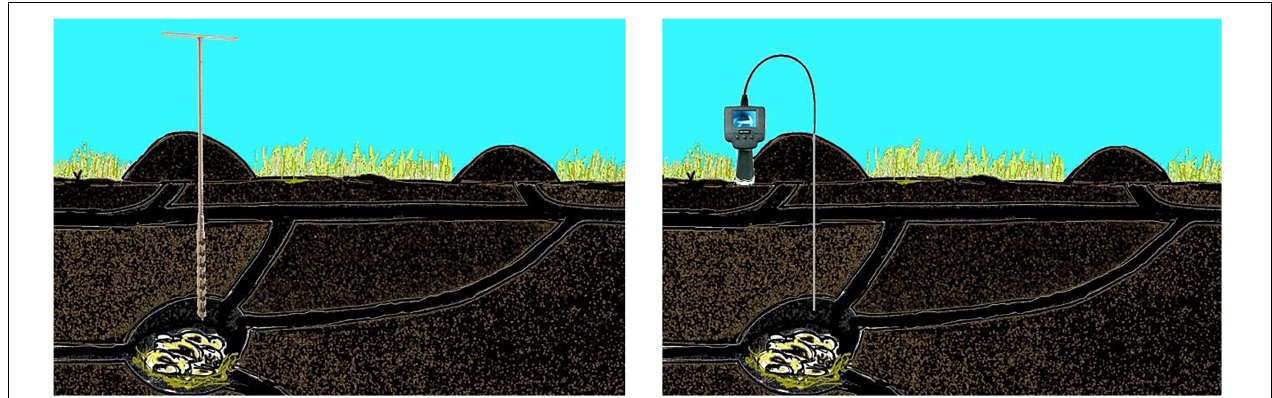
FIGURE 3 | Illustration of the proposed method of nest chamber drilling (Left) and endoscope monitoring (Right) .